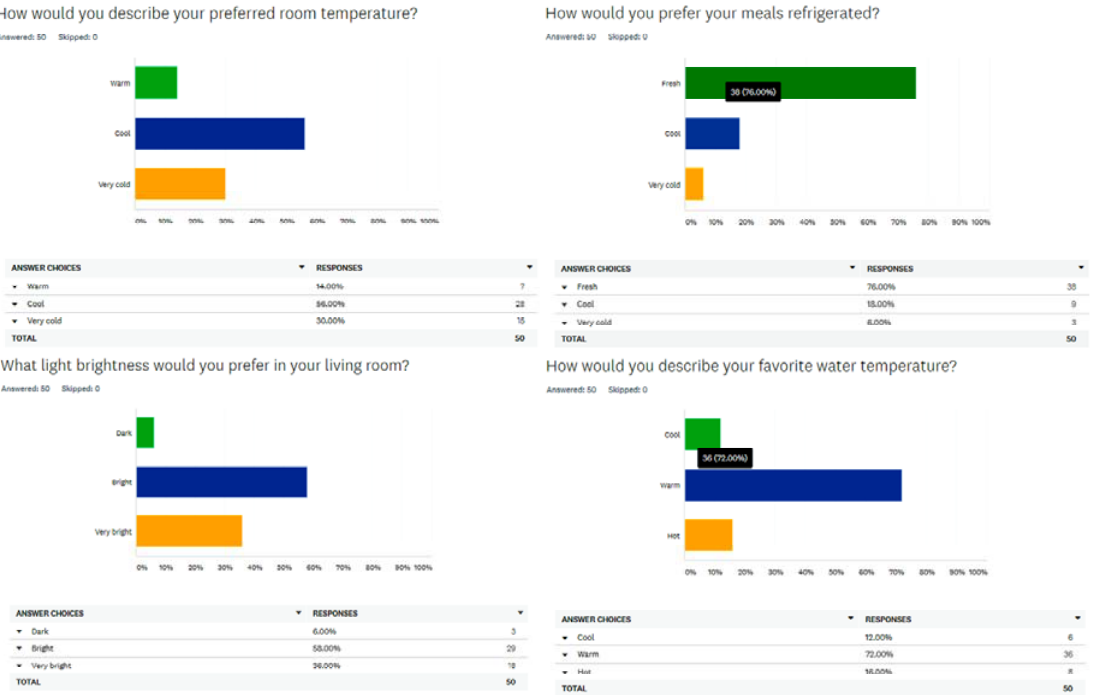
Figure 14. Results of survey questions related to thresholds.